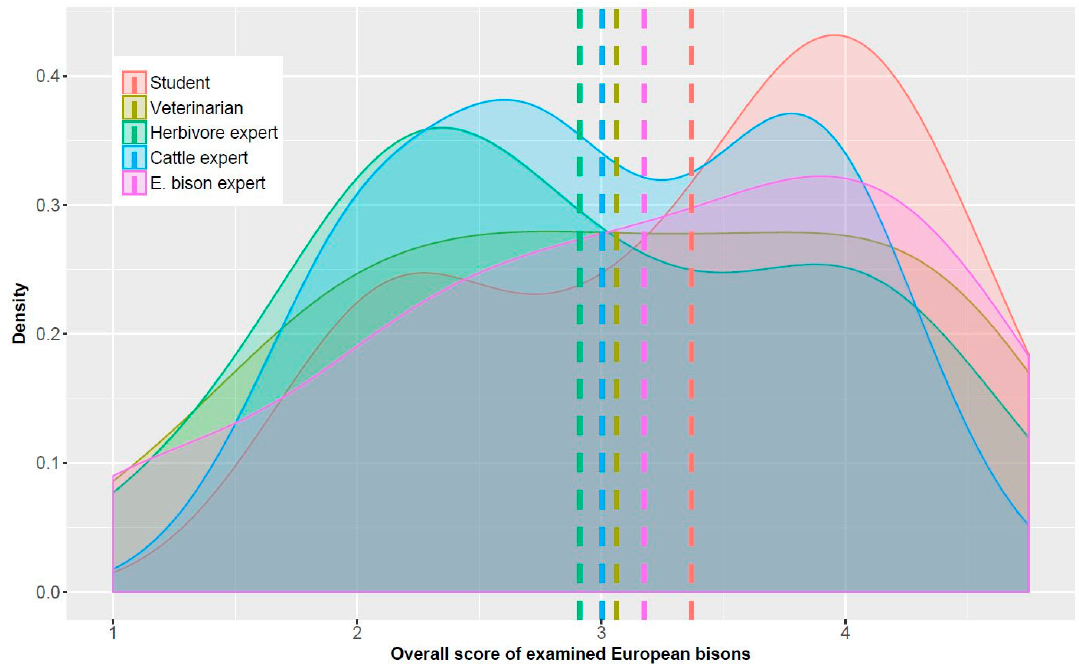
Figure 2. Density plot presenting frequencies of the overall scores per animal assigned by the assessors of different categories with different professional backgrounds. Dashed lines show the mean of the overall scores per category.